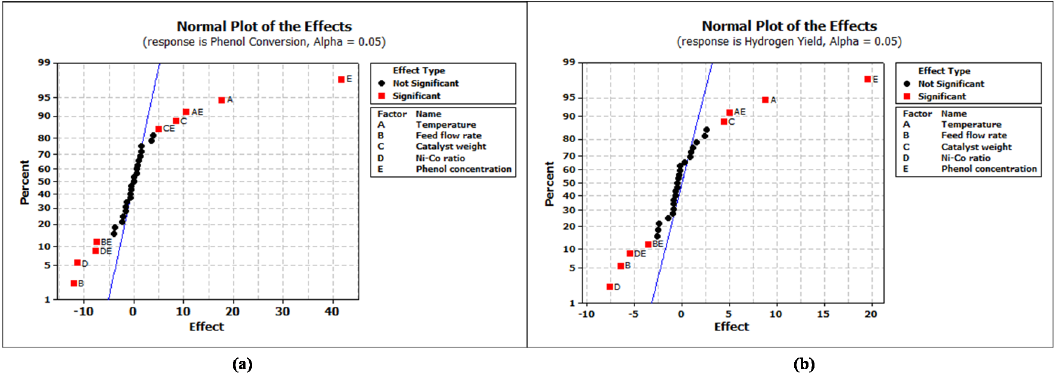
Figure 4. Normal plot for ( a ) Y 1 and ( b ) Y 2 .